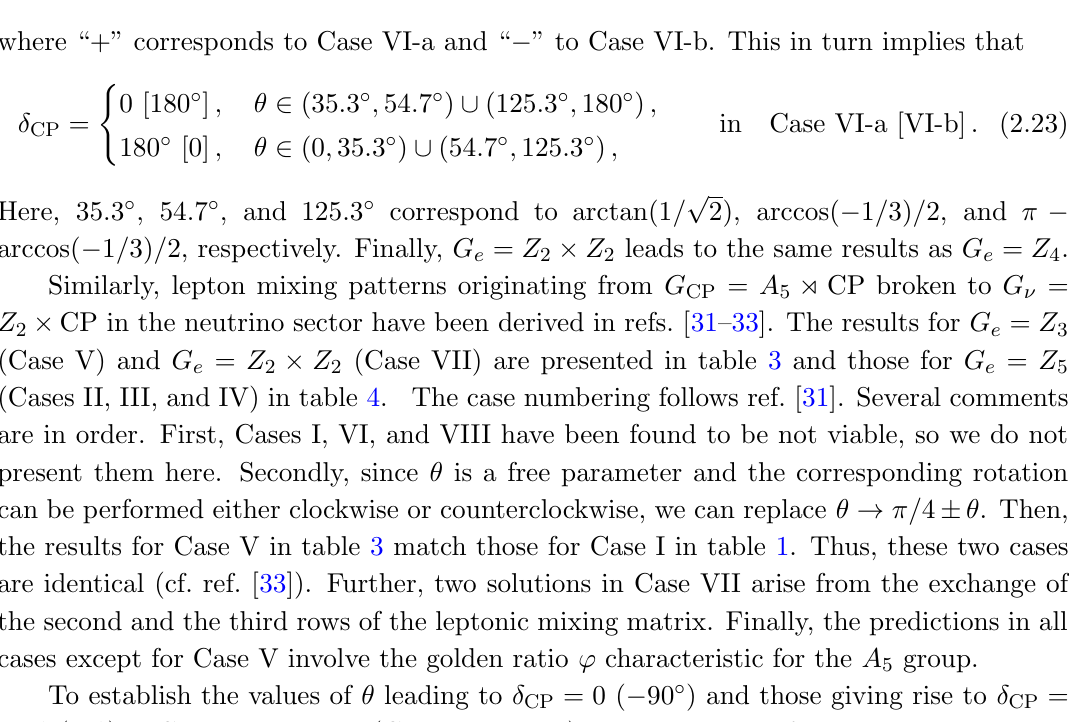
CP derived in (cid:2)